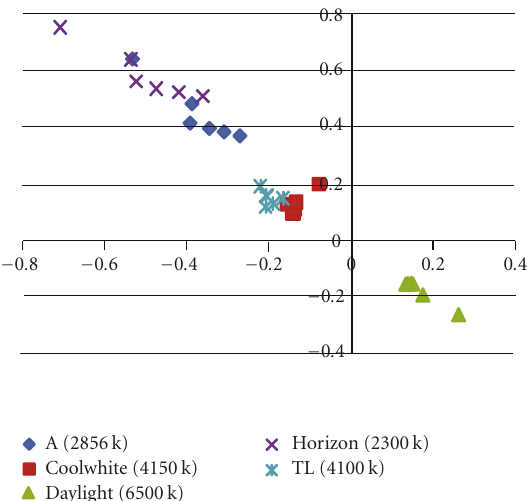
Figure 5: Predefined achromatic region (“A” is Incandescent Lamp (CIE-A) and “TL” is Tri- Phosphor Fluorescent (CIE-F11).).